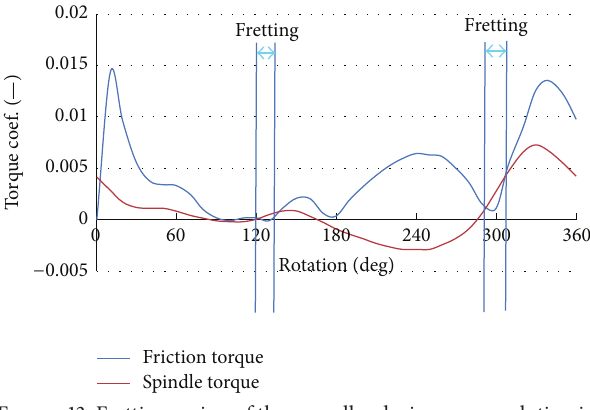
Figure 13: Fretting region of the propeller during one revolution in 𝑃/𝐷 = 0.5 .